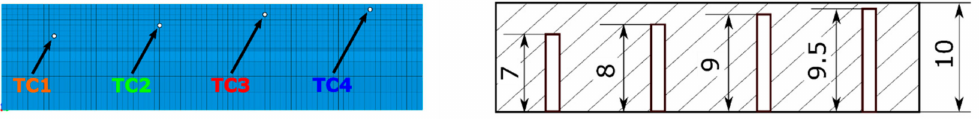
Figure 25. Scheme of thermocouple placement on the cross-section of samples in the axis of welded beads.